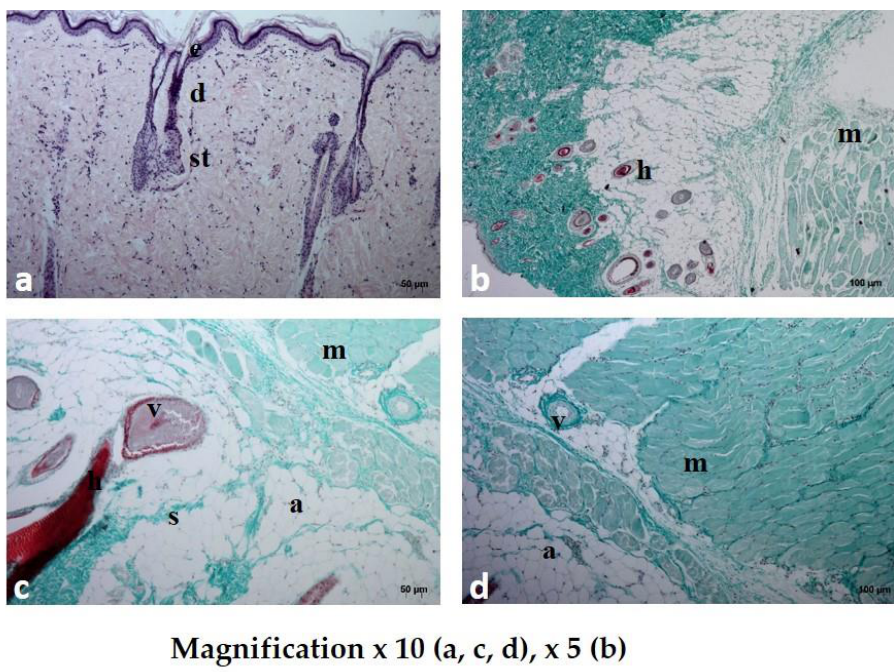
Figure 10. Histological examination of rat skin after the application of PVA / HPMC_B film with incorporated PVP-I (PVA / HPMC_B / T) stained with hematoxylin and eosin (HE) ( a ) and Masson’s trichrome ( b – d ) staining. The normal skin with a layered structure without inflammatory cells; e—epidermis; d—dermis; st—subcutaneous tissue; a—adipose tissue; m—muscle cells; h—hair; v—vessel; s—collagen septum. Table 3. The results of the blood biochemical analyses after the application of Spongostan, placebo film (PVA / HPMC_B / C), and film with incorporated PVP-I (PVA / HPMC_B / T).